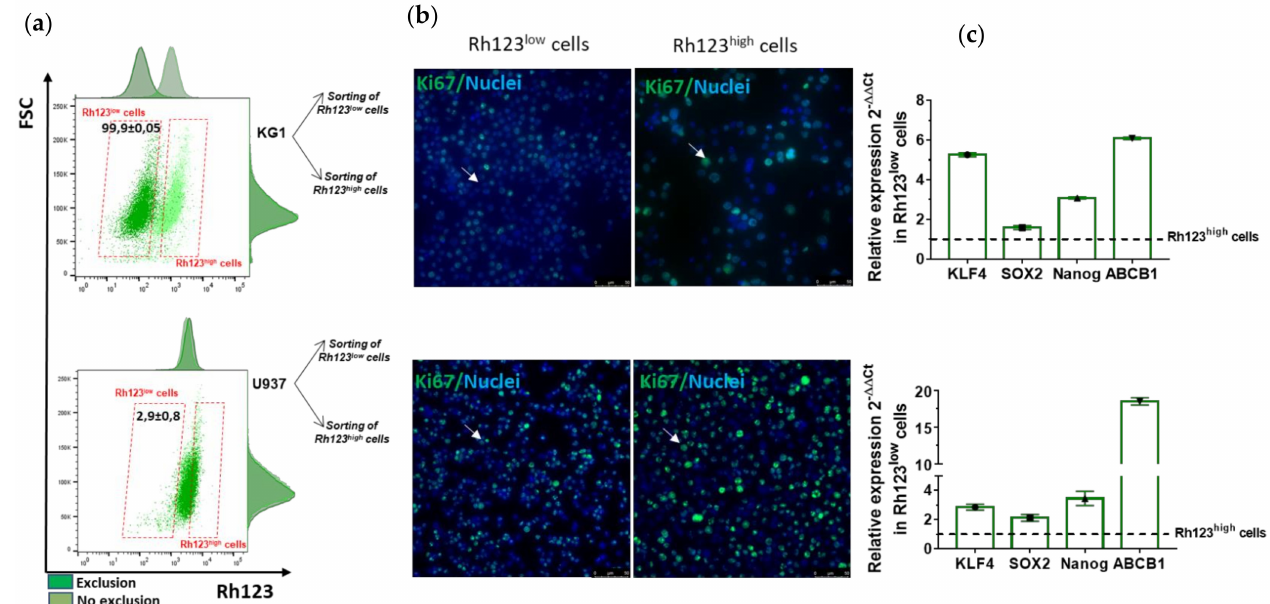
Figure 4. Flow cytometry identification of Rh123 low (ABCB1 high ) populations enriched with quiescent cells and stem cell markers in KG1 and U937 AML cell lines. ( a ) KG1 and U937 leukemic cells were incubated with 0.1 µ g/mL Rh123 probe for 20 min. After 60 min of exclusion of the Rh123 probe, the Rh123 low cell subpopulation appeared/is highlighted. ( b ) Ki67 (Alexa Fluor 488, green) and nuclear (Hoechst, blue) staining was then performed on cells sorted by FACS based on Rh123 probe exclusion. Ki67-negative or Ki67-low-expressing cells were considered quiescent cells or slow-cycling cells, respectively. White arrows indicate quiescent cells in the Rh123 low compartment and cycling cells in the Rh123 high cell compartment. ( c ) Stemness-associated gene expression was analyzed by RT–qPCR and is shown in the Rh123 low cells relative to the expression of the corresponding genes in Rh123 high cells. The relative expression ratio for each gene was calculated by the 2 − ∆∆ Ct method. The calculated values represent the expression level of each gene relative to the expression of B2M used herein as an endogenous control. Histograms present the mean results from three independent